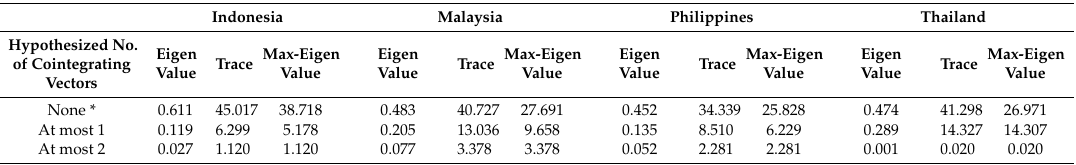
Table 4. Johansen cointegration